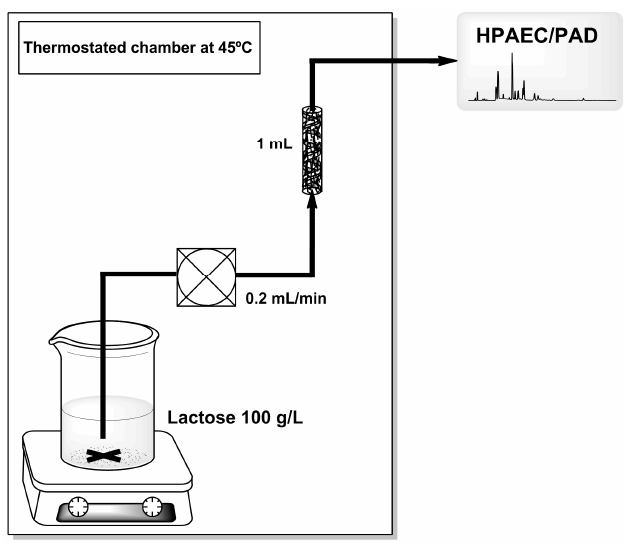
Figure 8. Schematic diagram of the continuous PBR used in this study to synthesize GOS.